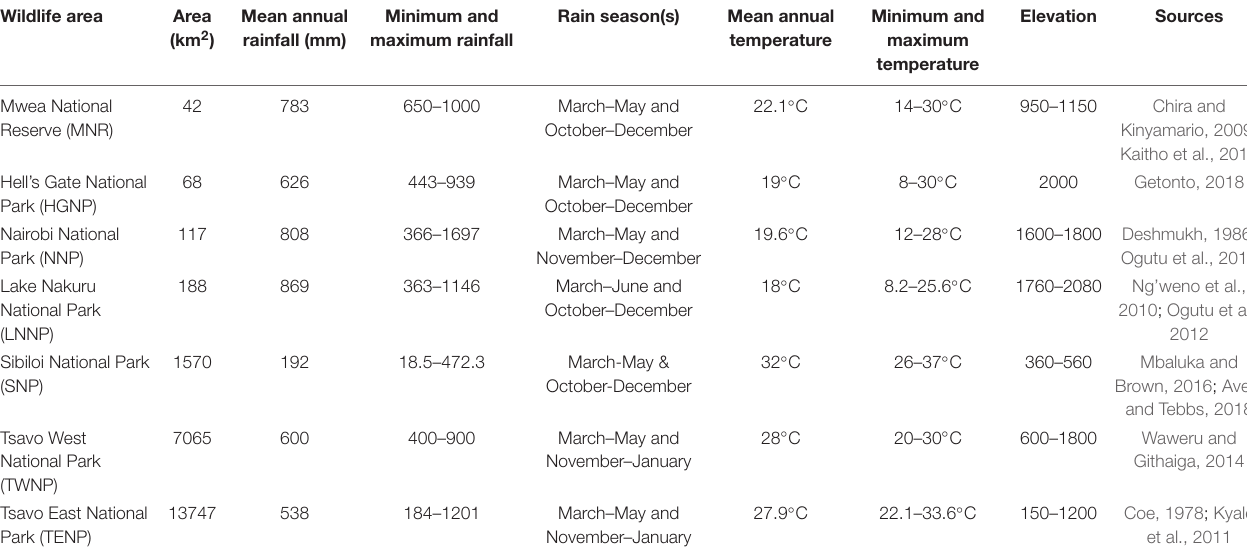
FIGURE 1 | The spatial distribution of Kenya’s protected wildlife areas (NP, National Park; NR, National Reserve) showing focal wildlife areas examined for anthrax outbreaks. Focal wildlife areas are indicated in red and other wildlife areas are indicated by green. TABLE 1 | Areal coverage, climatic and topographic variables of focal wildlife areas in Kenya